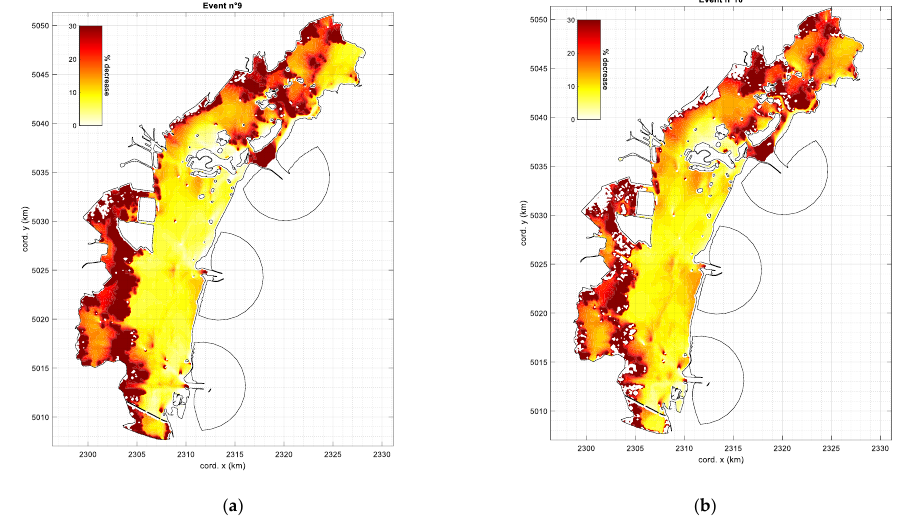
Figure 10. Percentage decrease between the modelled Hs in the closed and open barrier scenarios for ( a ) event no. 9 (1 November 2021) and ( b ) no. 10 (4 November 2021). In the red, the decreases are larger than 30%.